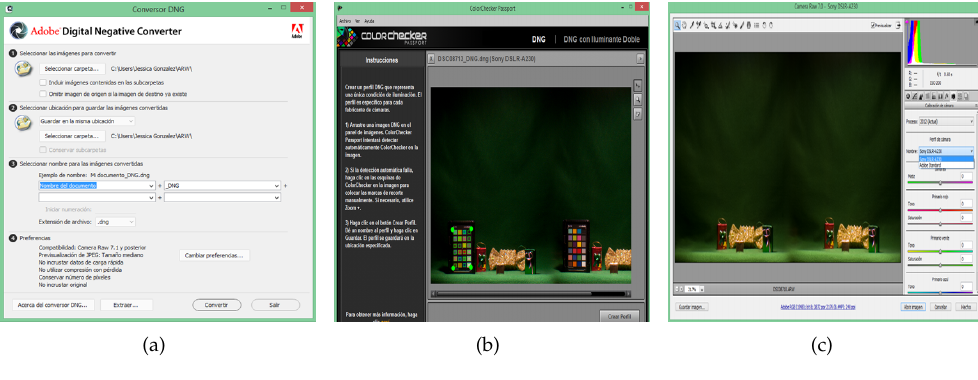
Figure 13. Color calibration: ( a ) Adobe DNG Converter , ( b ) Color Checker Passport Software, and ( c ) Adobe Photoshop CS6 .